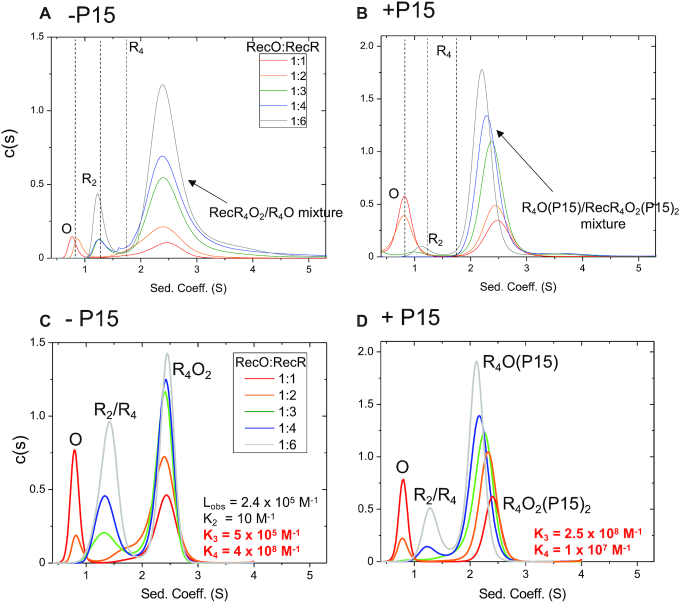
RecO binds to the RecR tetramer. RecO (1.5 μM) was titrated with increasing concentrations of RecR (1.5–9 μM) by sedimentation velocity (monitored at 230 nm) in the presence and absence of SSB-Ct peptide (P15) in buffer BTP (pH 8.0) at 25.0°C. (A) c(s) distribution profiles in the absence of P15 at the indicated molar ratios of [RecO]:[RecR] (monomers). The dotted lines show sedimentation coefficients for individual RecO, RecR2 and RecR4 species determined from isolated proteins. At 1:1 (red) and 1:2 (orange), the distributions show free RecO species at 0.8 S and a RecOR complex at 2.5 S. At molar ratios of 1:3 (green), 1:4 (blue), 1:6 (gray), free RecR dimer is observed at 1.2 S in addition to RecOR complex peaks at ∼2.5 S that show a slight shift to the left with increasing [RecR]. Since free RecO is not observed at the molar ratio of 1:3 and beyond, the observation of free RecR2 peak with RecOR peaks that shift to a lower sedimentation coefficient value indicate that a mixture of RecOR complex is present and that a RecOR complex with a lower MW forms at higher [RecR]. (B) In the presence of P15, free RecO is observed at 0.8 S for 1:1 (red) and 1:2 (orange) molar ratios in addition to a RecOR complex peak at ∼2.5 S. A free RecR2 species (1.2 S) is observed at higher [RecR]. Note that the RecOR complex peaks notably shift from 2.5 to 2.3 S at higher [RecR], indicating a significant formation of RecOR complex of lower MW. This shift is notably more significant than in the absence of P15. Panels (c) and (d) show simulations of titration of RecO (1.5 μM) with RecR (1.5–9 μM) by sedimentation velocity experiments monitoring at 230 nm at 42 000 rpm in buffer BTP (pH 8.0) at 25°C. (C) c(s) distribution profiles of simulated data with K3 = 5 × 105 and K4 = 4 × 108 M−1 describe the experimental data best in the absence of P15. A free RecO species is observed at 0.8 S, free RecR species at ∼1.2–1.4 S, and RecR4O2 complex species at ∼2.5 S. Simulations show that all of RecO is bound for RecR \documentclass[12pt]{minimal}
\usepackage{amsmath}
\usepackage{wasysym}
\usepackage{amsfonts}
\usepackage{amssymb}
\usepackage{amsbsy}
\usepackage{upgreek}
\usepackage{mathrsfs}
\setlength{\oddsidemargin}{-69pt}
\begin{document}
}{}$ \ge$\end{document} 4.5 μM as in experiments and the area of free RecR species increase with increasing [RecR]. The RecOR complex peak is positioned at 2.5 S, reflecting that primarily RecR4O2 complex is present in a mixture of RecR4O and RecR4O2 complexes. The relative increase and decrease of areas of each species are similar to those in experiments, but the absolute areas differ, which is likely due to the less precise extinction coefficients at 230 nm than those at 280 nm, and we consider these differences in peak areas to be minor. (D) In the presence of P15, simulated data with K3 = 2.5 × 108 and K4 = 1 × 107 M−1 describe the experimental data best.